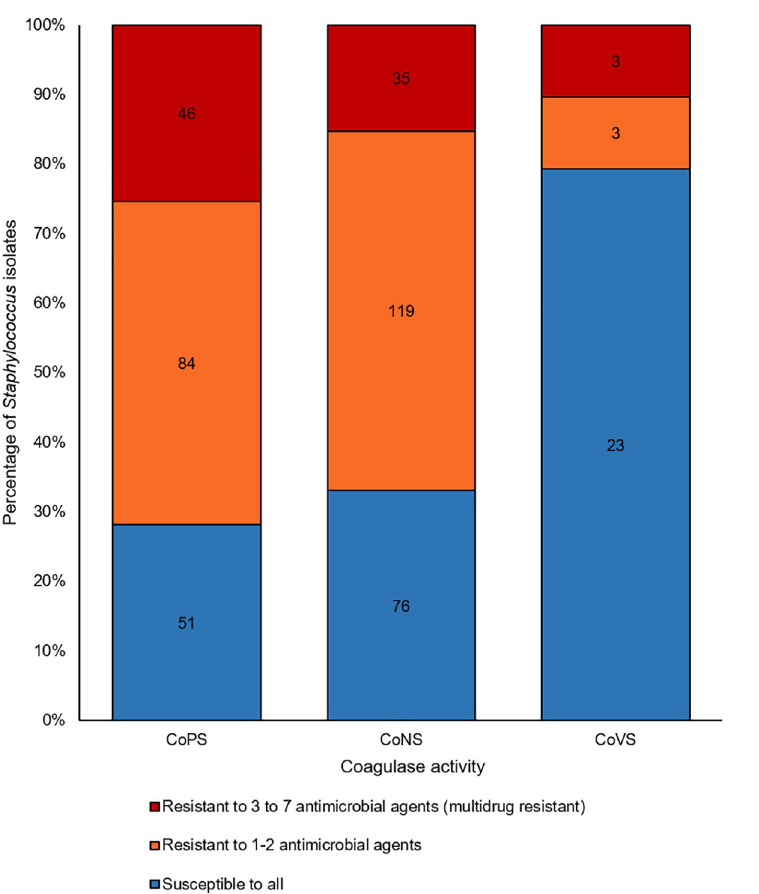
Fig 4. Proportions of multidrug resistant